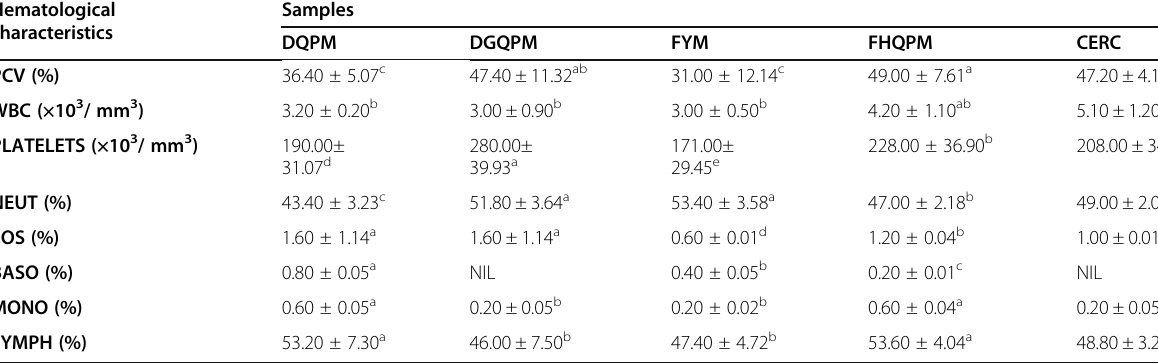
Table 5 Hematological characteristics of rats fed with the blends of maize and almond seed flour Hematological